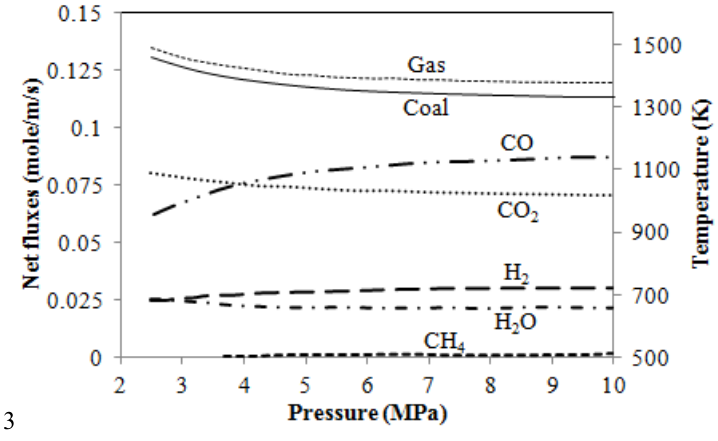
Figure 29. Net fluxes and temperature as a function of process pressure for oxygen injection rate = 0.1 mol/m/s and water injection rate = 0.05 mol/m/s [55].